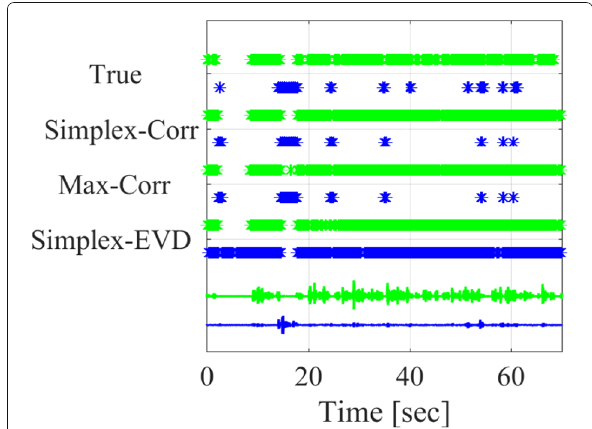
Fig. 8 Blue and green waveforms of microphones attached to a therapist and to a patient, respectively. The true and the estimated time instances with activity of each speaker are marked by asterisks